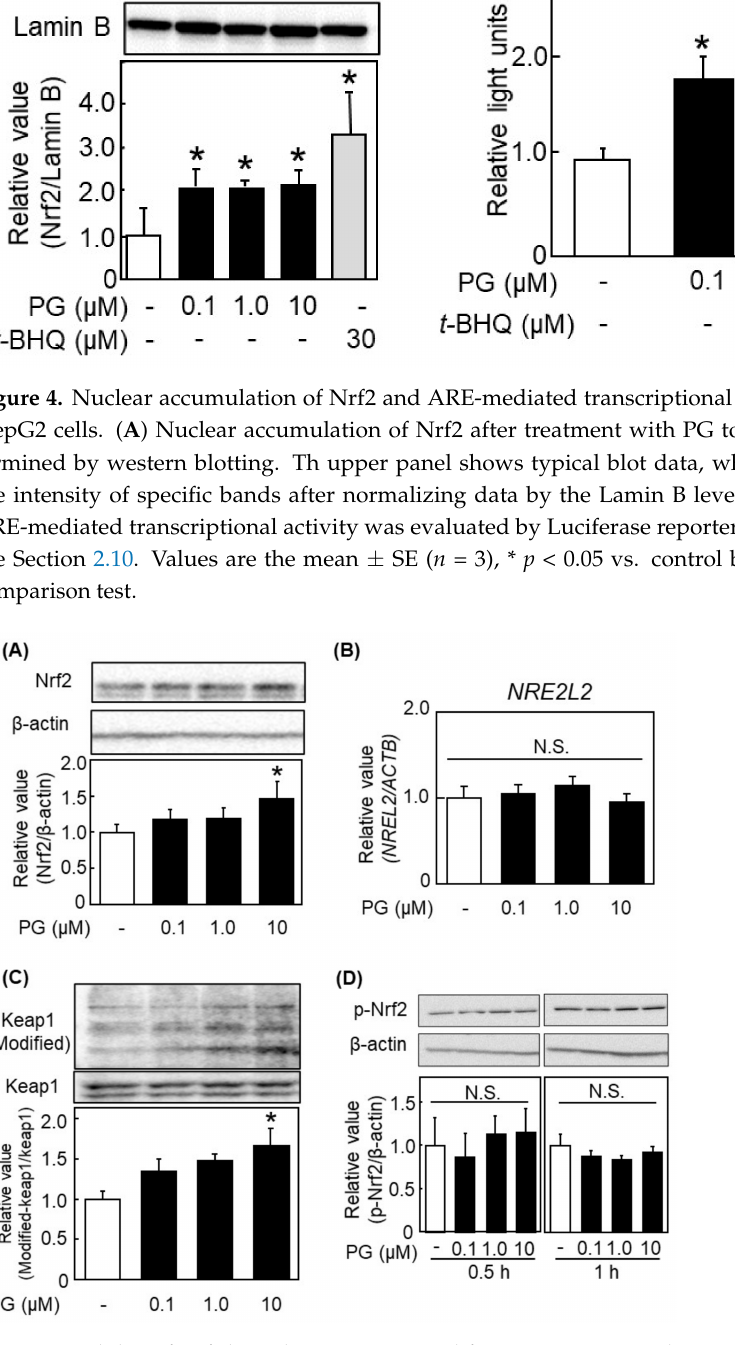
Figure 5. Stability of Nrf2 by inducing Keap1 modification in PG-treated HepG2 cells. After treatment with PG to HepG2 cells, expression of ( A ) Nrf2 and ( B ) its gene ( NFE2L2 ) was measured by western blotting and qPCR, respectively. ( C ) Kelch-like ECH-associated protein 1 (Keap1) and its modification, and ( D ) phosphorylation of Nrf2 was determined by western blotting. after treatment with PG to the cells. ( A , C , D ), Upper panels show typical blot data, while bottom ones are the intensity of specific bands after normalizing data by the β -actin level. Values are the mean ± SE ( n = 3), * p < 0.05 vs. control by Dunnett’s multiple comparison test. N.S.: Not